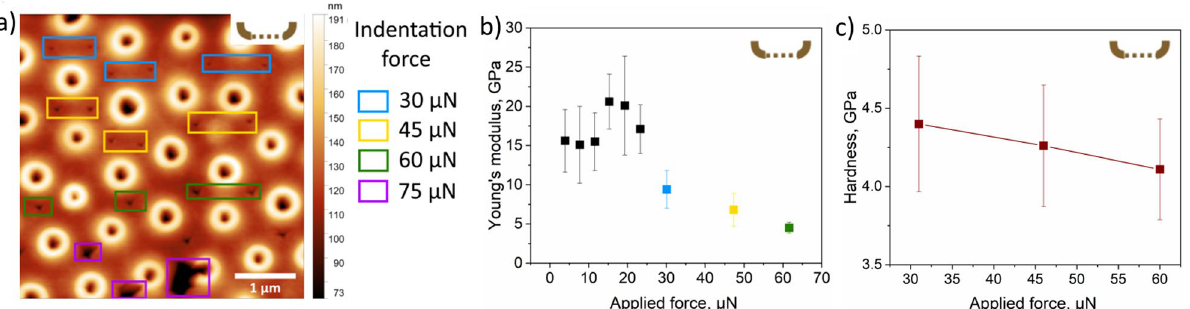
Figure 4. AFM indentation at specific points of a cleaned inner valve. ( a ) Inner surface of a frustule measured by the stiff probe after indentation at specific points by applying different indentation force, ( b ) Young’s modulus calculated using the Derjaguin–Muller–Toropov (DMT) model at different applied forces after averaging over 10 points, ( c ) the dependence of hardness on the applied